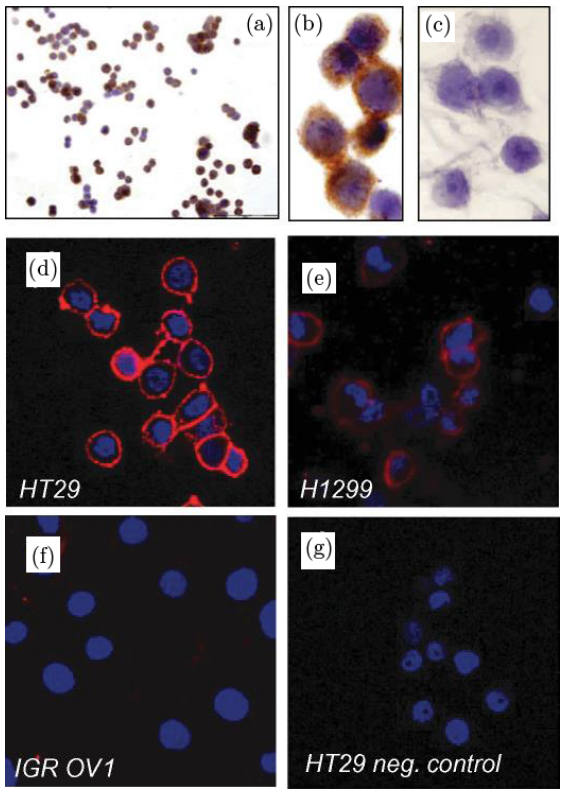
Fig. 4. Speci¯c labeling of various tumor cells by HPA (the GalNAc-speci¯c lectin from Helix pomatia ). (a) Biotin-HPA labeling of HT29 cancer colon cells, Scale bar is 100 (cid:1) m. (b) Enlarged image of the labeled cells. (c) Negative control in the presence of 100 mM GalNAc. Cy5-HPA labeling of (d) HT29 colon cancer cell lines, and (e) human nonsmall cell lung cancer H1299. (f) Negative labeling of IGROV1 ovarian cancer cell lines and (g) control experiment in presence of 100 mM GalNAc. (d) – (g): nuclei are blue stained with 5 (cid:1) M Hoechst 33342). Adapted with permission from Ref.